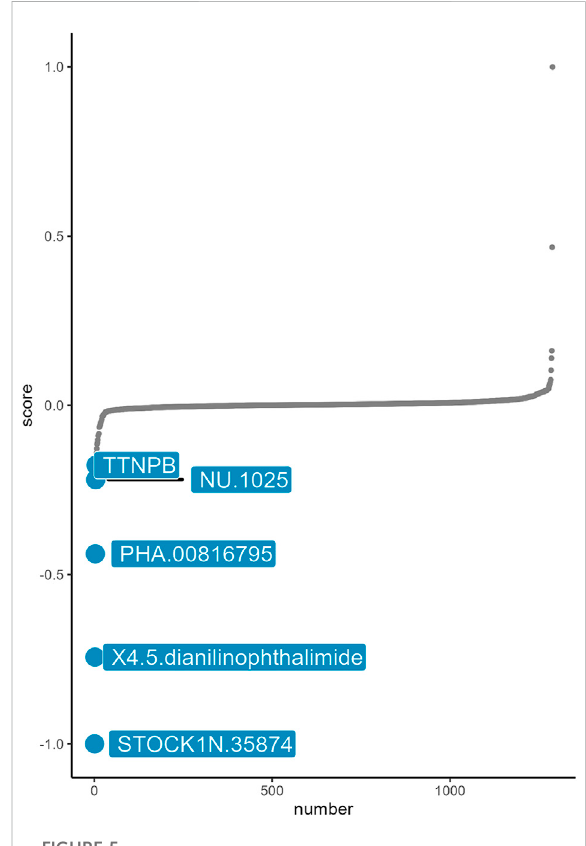
FIGURE 5 Small molecular compounds identi fi ed by connectivity